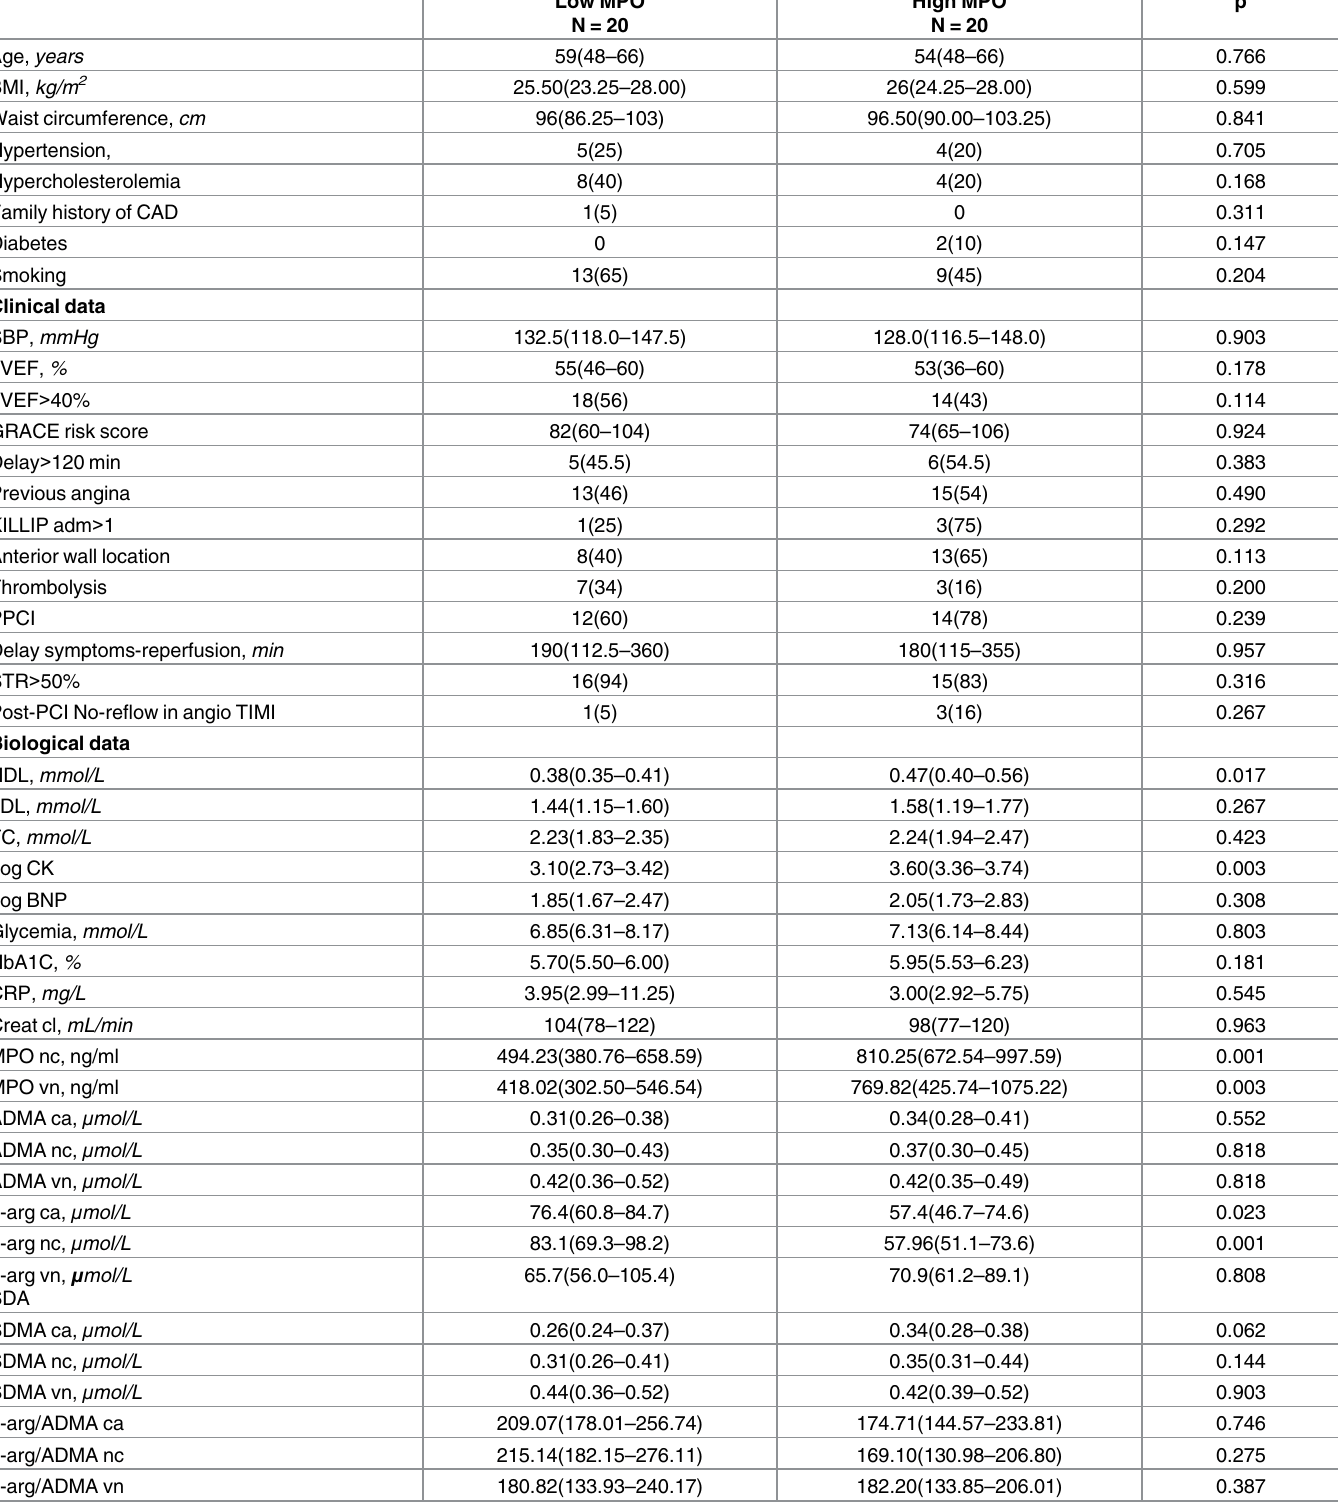
Table 1. Patients’ characteristics. Data are presented as n (%) or median